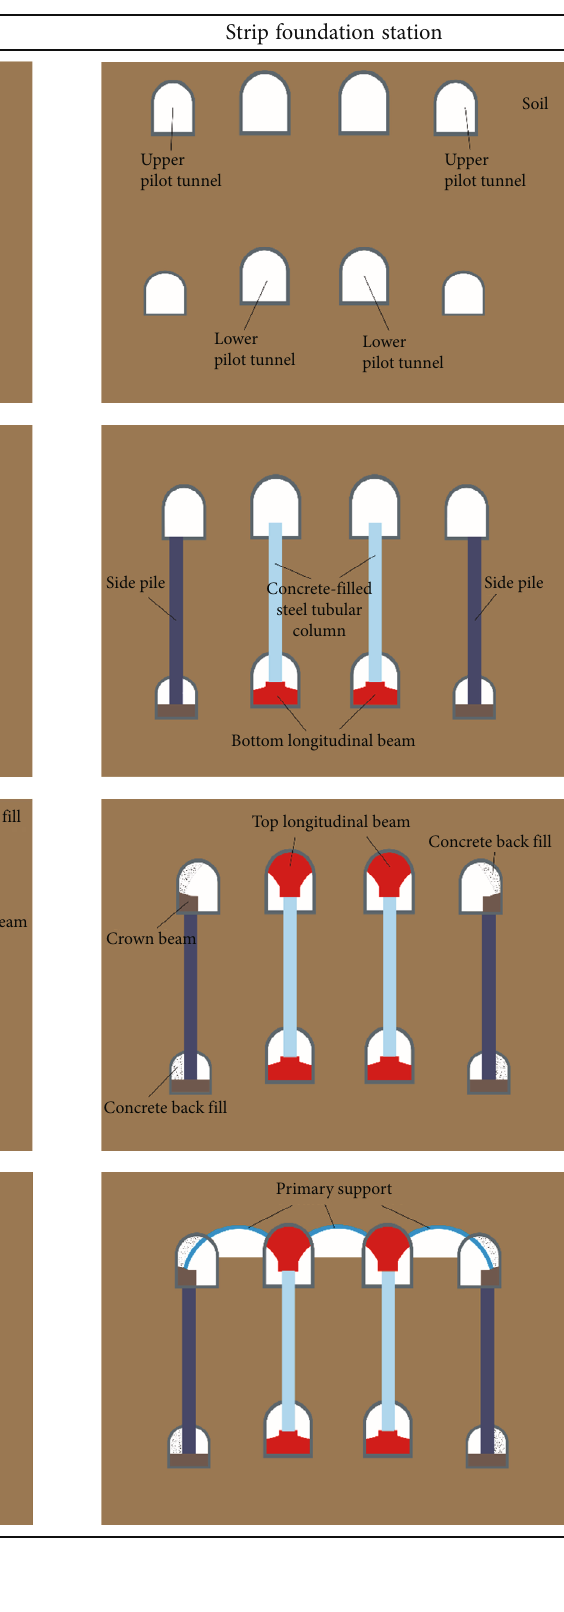
Table 1: Construction sequence of the PBA